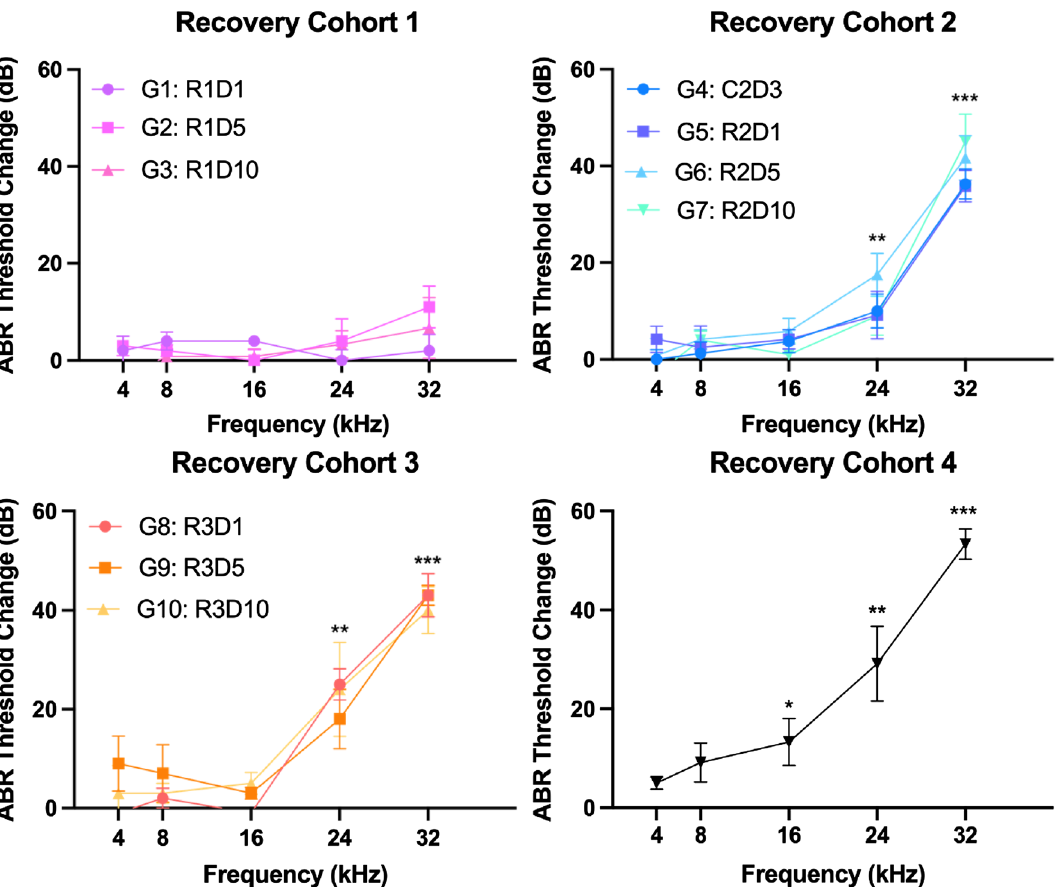
Figure 2. ABR threshold differences at time of sacrifice. Error bars represent standard error of the mean (SEM). Asterisks represent significance against control, * < 0.05, ** < 0.01, *** <